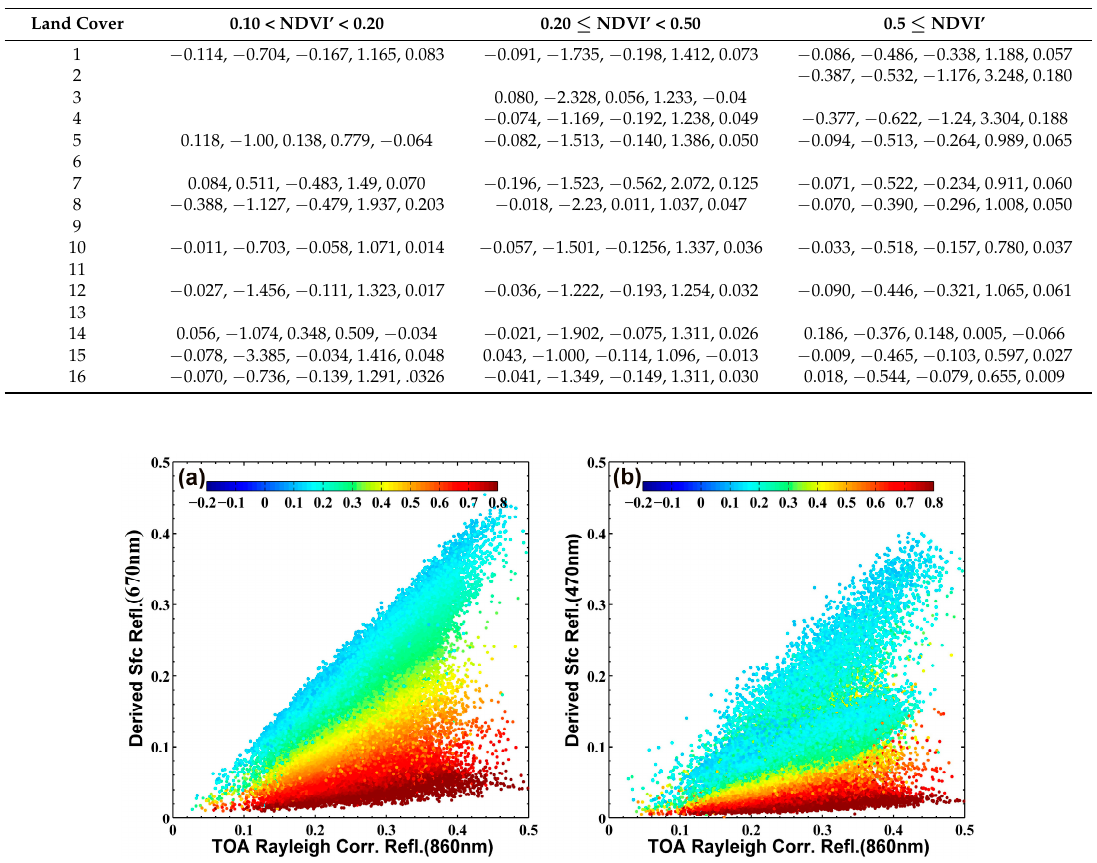
Table 9. Surface Reflectance Coefficients for 0.67 µ m for DJF.